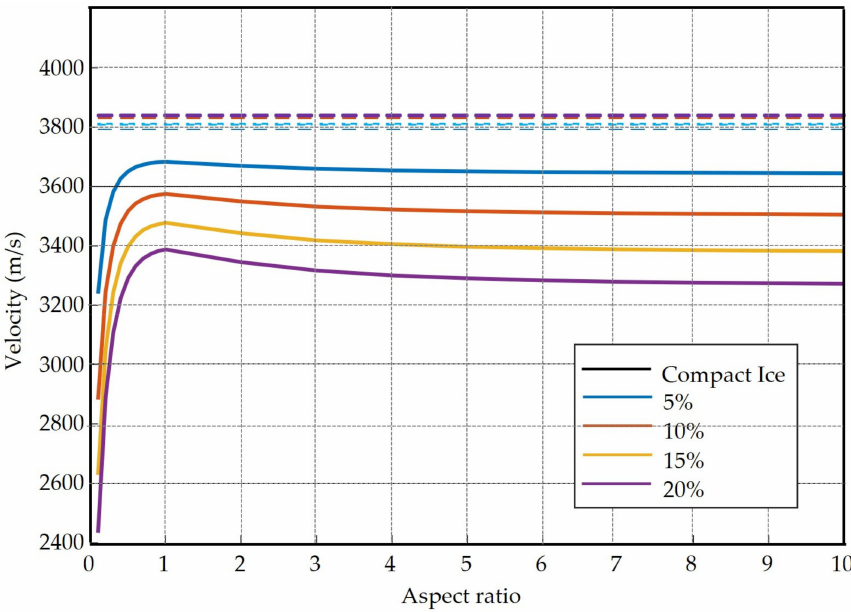
Figure 17. Comparison of theoretical and measured velocities of compact ice drop